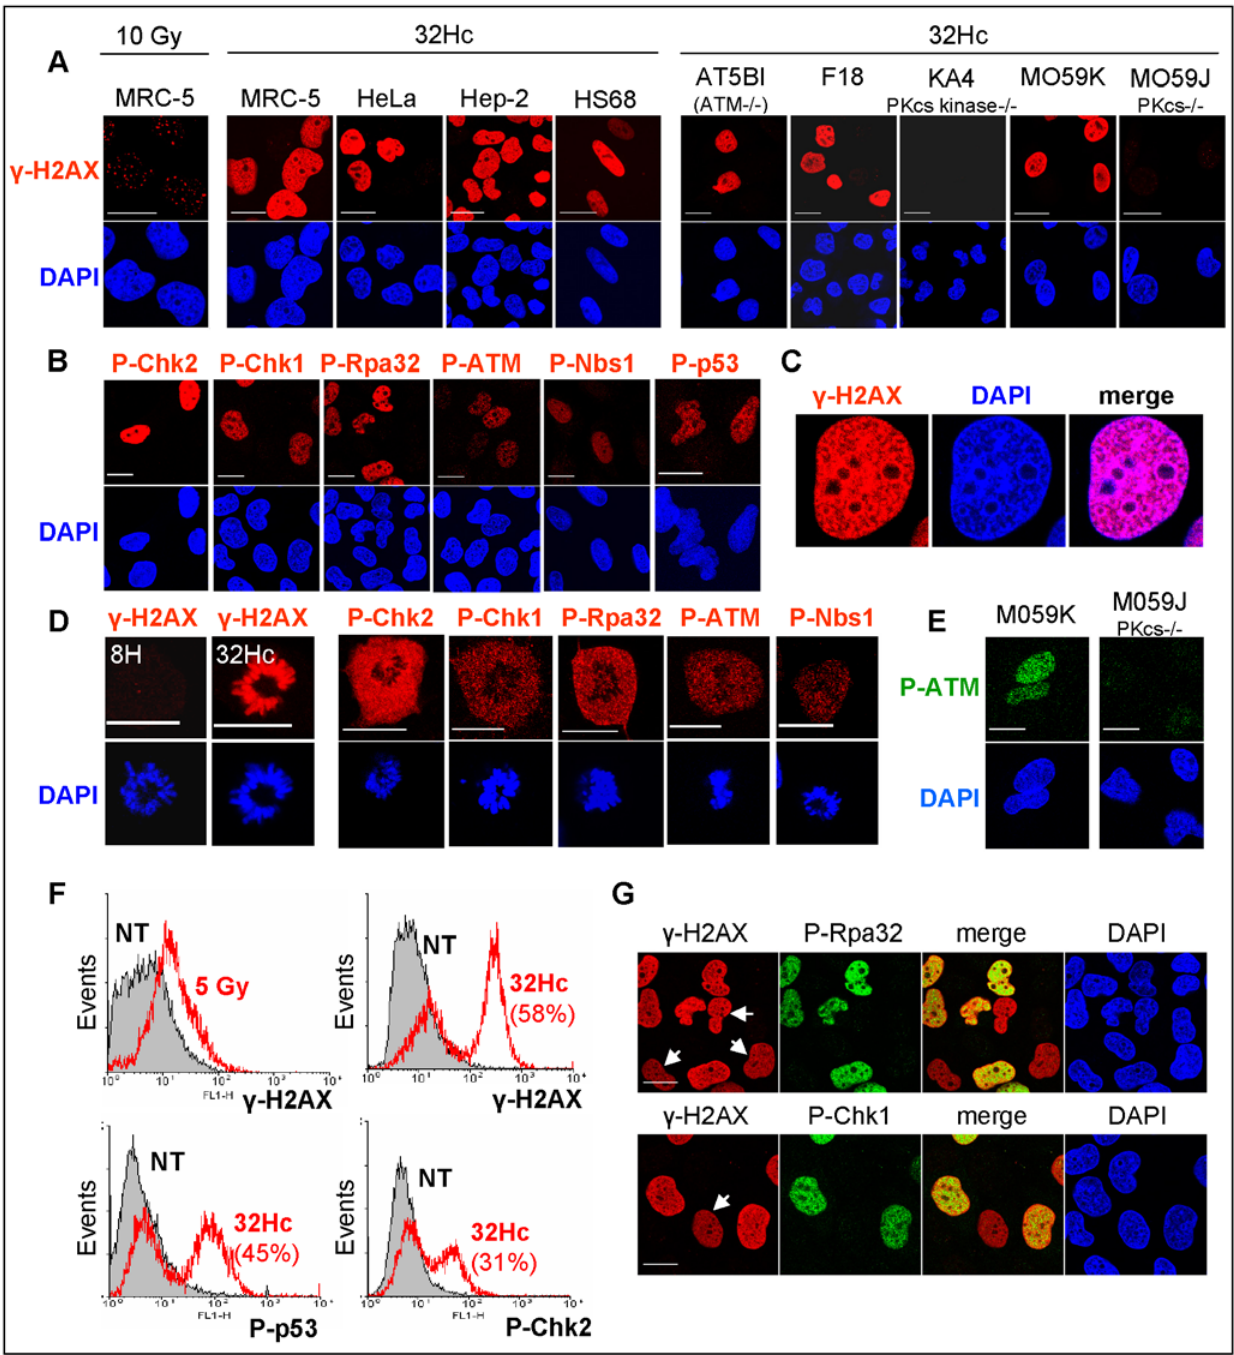
Figure 3. Phosphorylation pattern of DNA damage signaling proteins in 32Hc treated cells. (A) Immunostaining of c -H2AX in MRC-5 cells after 10 Gy IR (left panel) and in various cell lines after 32Hc treatment. Cells were fixed 2 h after IR and 1 h after the end of transfection. (B-D) Phosphorylation pattern of different DDR proteins in MRC-5 cells after 32Hc treatment. Cells were immunostained with antibodies against c -H2AX, Chk2-T68P, Chk1-S345P, Rpa32-S4/8P, ATM-S1981P, Nbs1-S343P, p53-S15P as indicated. (B) Interphase cells. (C) Co-localization of c -H2AX and DNA (D) M-Phase cells. (E) 32Hc treated M059K and M059J cells were probed for ATM-S1981P. (F) Flow cytometry analysis of not-treated (NT, gray), irradiated (5 Gy, upper left panel) or 32Hc transfected MRC-5 cells with immunostaining for the indicated phosphoproteins. Percentages reflect the proportion of the ‘‘positive’’ cells after 32Hc treatment. (G) Co-staining of c -H2AX and Rpa32-S4/8P (upper panel) or Chk1-S345P (lower panel). Arrows indicate c -H2AX positive cells that are negative for the other phosphoprotein. Scale bar: 20 m m.